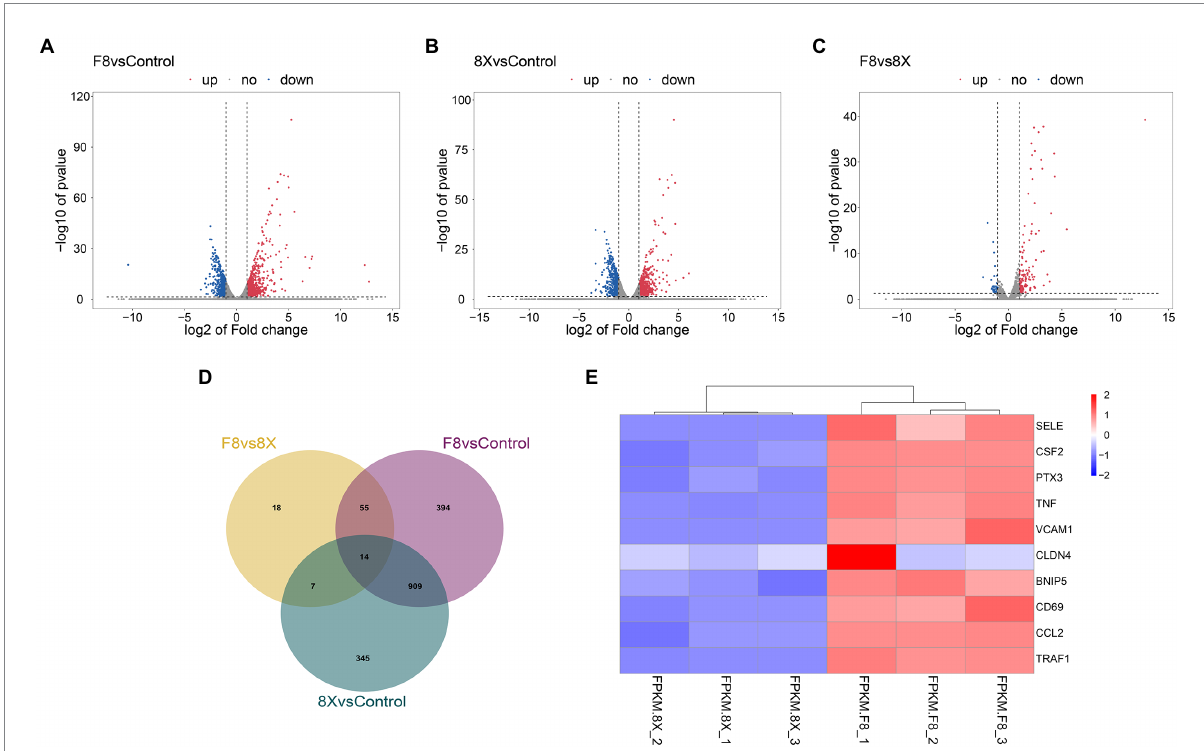
FIGURE 2 Volcano plots showing the DEGs between 8X and control (A) , F8 and control (B) , and the 8X and F8 (C) . (D) Venn diagram of the identified DEGs shared among the above three groups. (E) Heatmap of the top 10 DEGs between 8X and F8 groups.